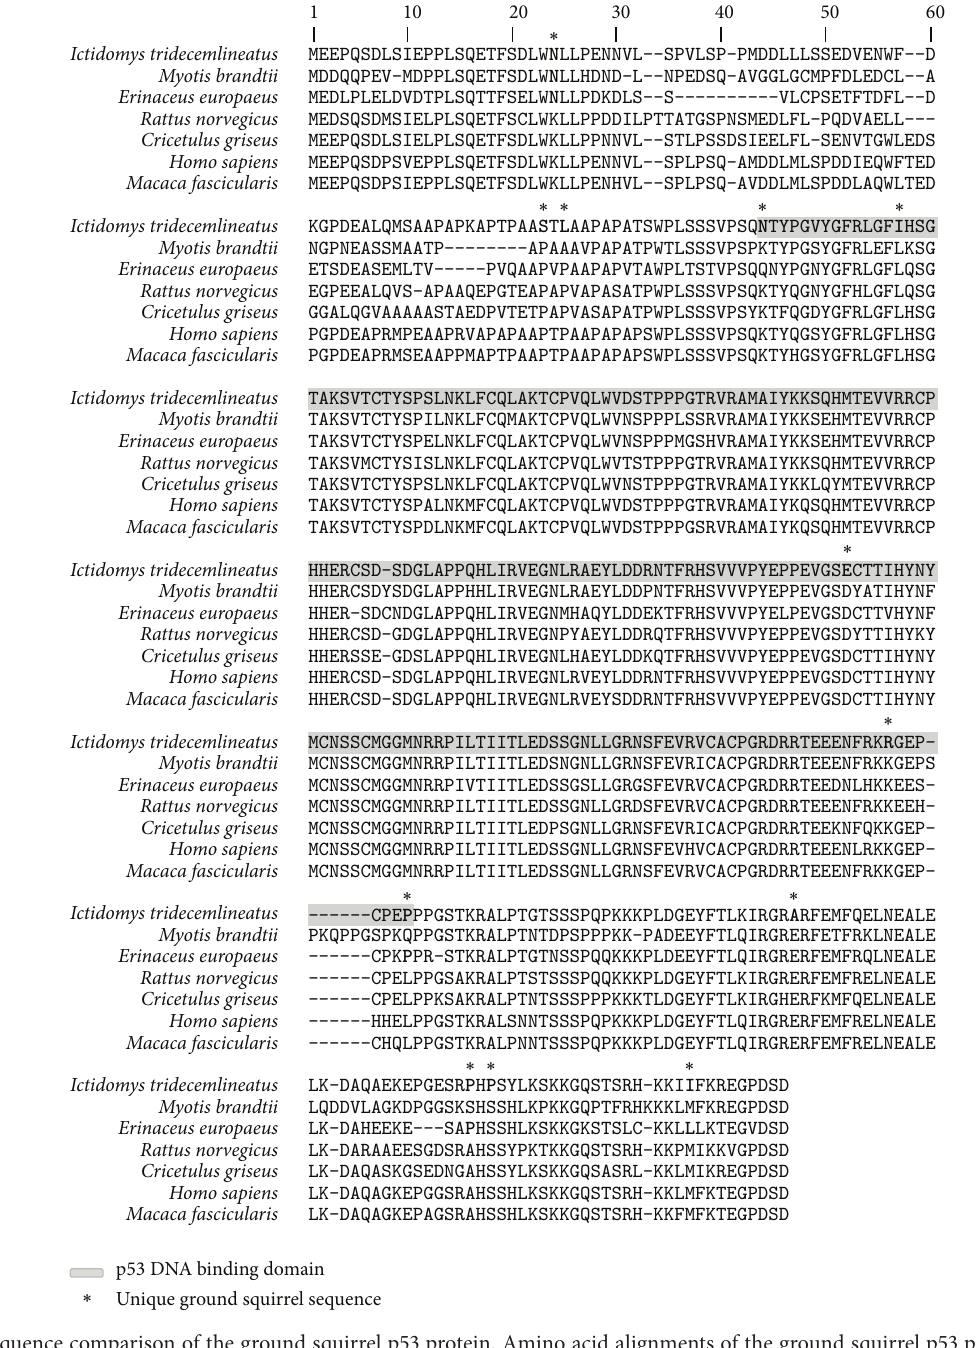
during p53 activation. During the arousal stages, the elevated expressions of 14-3-3, p21, and gadd-45 𝛼 observed during late torpor were normalized back to the control